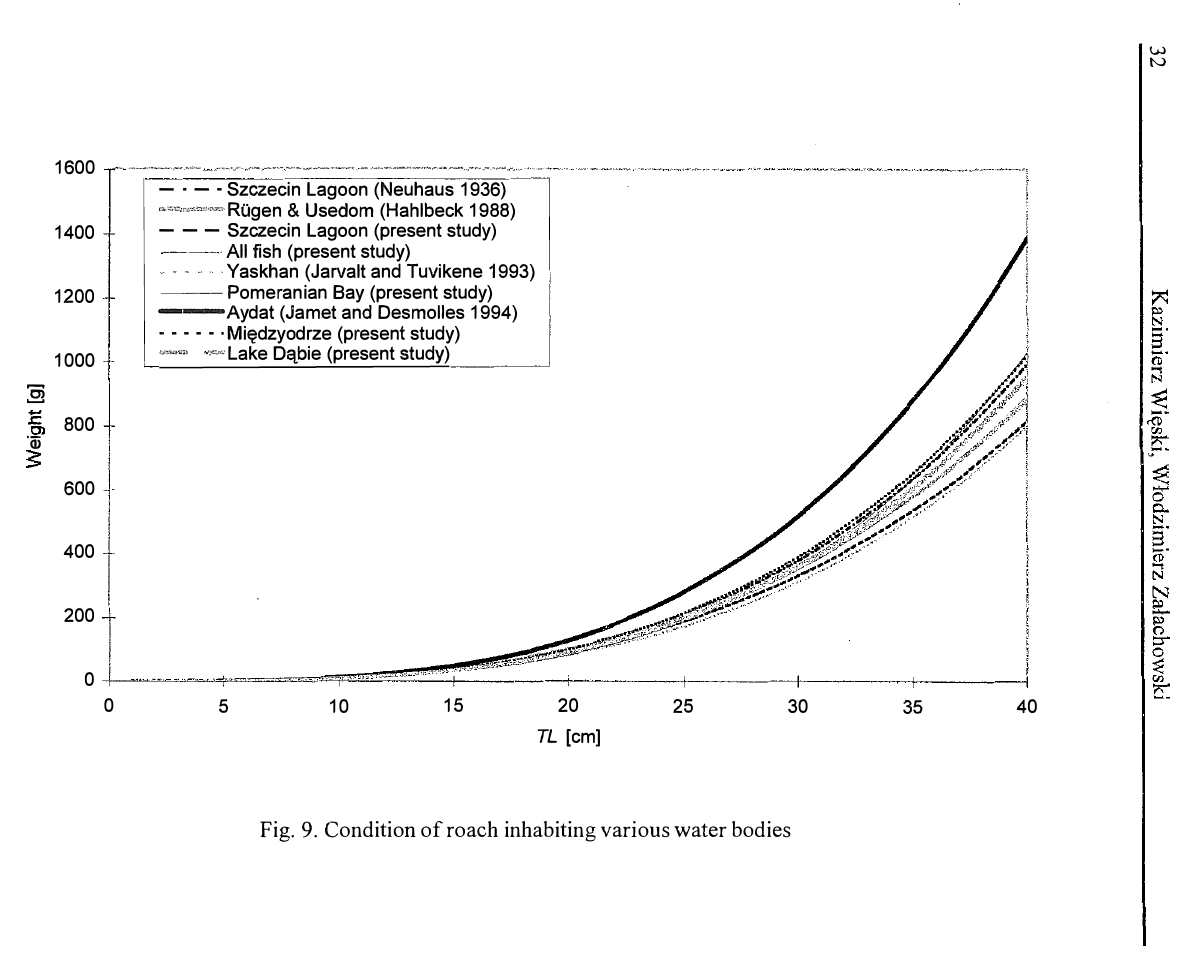
Fig. 9. Condition ofroach inhabiting various water